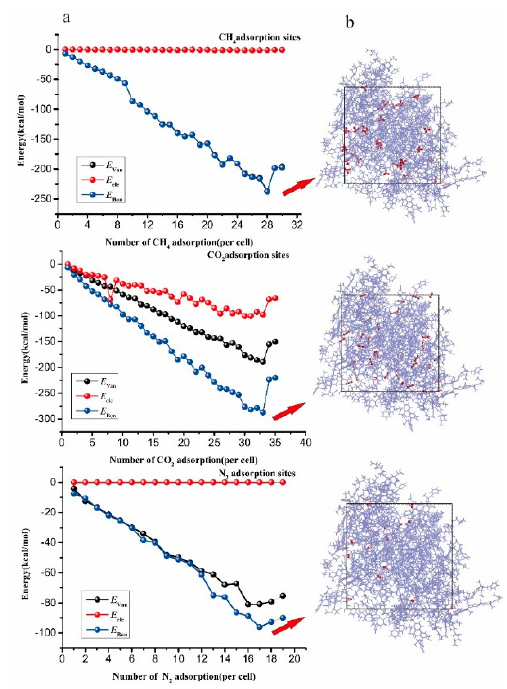
Figure 7. Total energy change and configuration of the CO 2 / CH 4 / N 2 saturated adsorption process. ( a ) the total energy change of CO 2 / CH 4 / N 2 saturated adsorption process. ( b ) the configuration of the CO 2 / CH 4 / N 2 saturated adsorption proes.